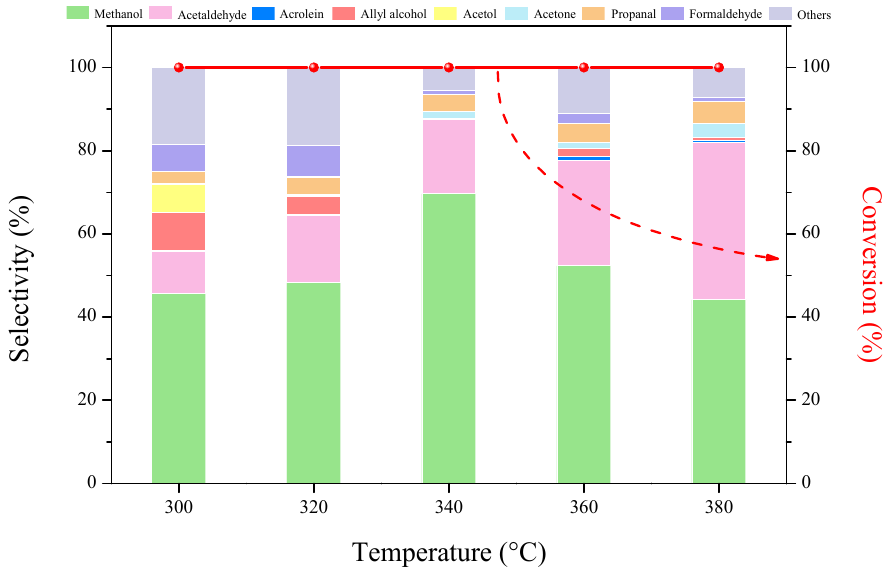
Figure 8. Glycerol conversion and product selectivity over 10%CaO/HZSM-5(38) catalysts at different temperatures. Reaction conditions: feed flow = 0.01 mL min − 1 (15 wt% glycerol/H 2 O), catalyst weight = 0.20 g, inert carrier = 20 mL min − 1 , TOS = 2 h.